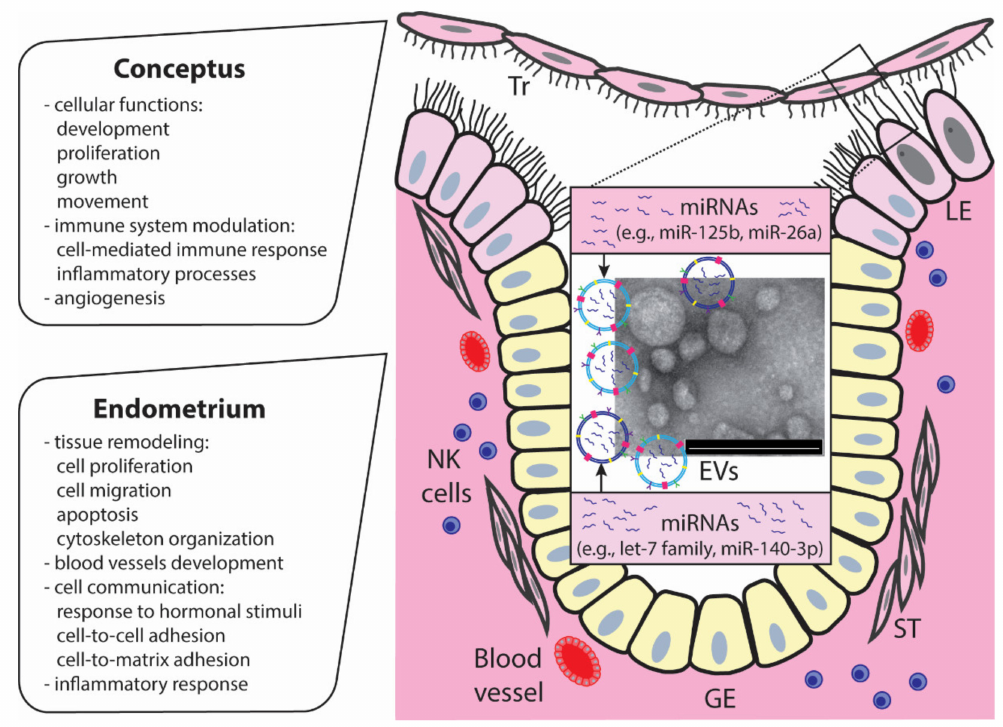
Figure 3. Peri-implantation events are governed by various biological molecules, including miRNAs produced by the endometrium and conceptus in pigs. miRNAs carried by EVs participate in reciprocal communication between the conceptus and endometrium, regulating the expression of genes involved in several pathways crucial for successful implantation. Tr, trophoblast; LE, luminal epithelium; GE, glandular epithelium; ST, stroma; NK cells, natural killer cells. Scale bar, 200 µ